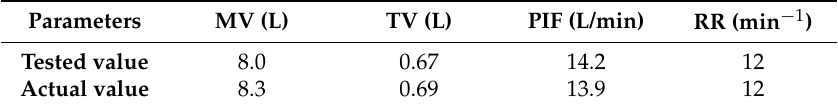
Figure 12. Simulation respiration signal. Table 2. Test results of respiratory parameters.